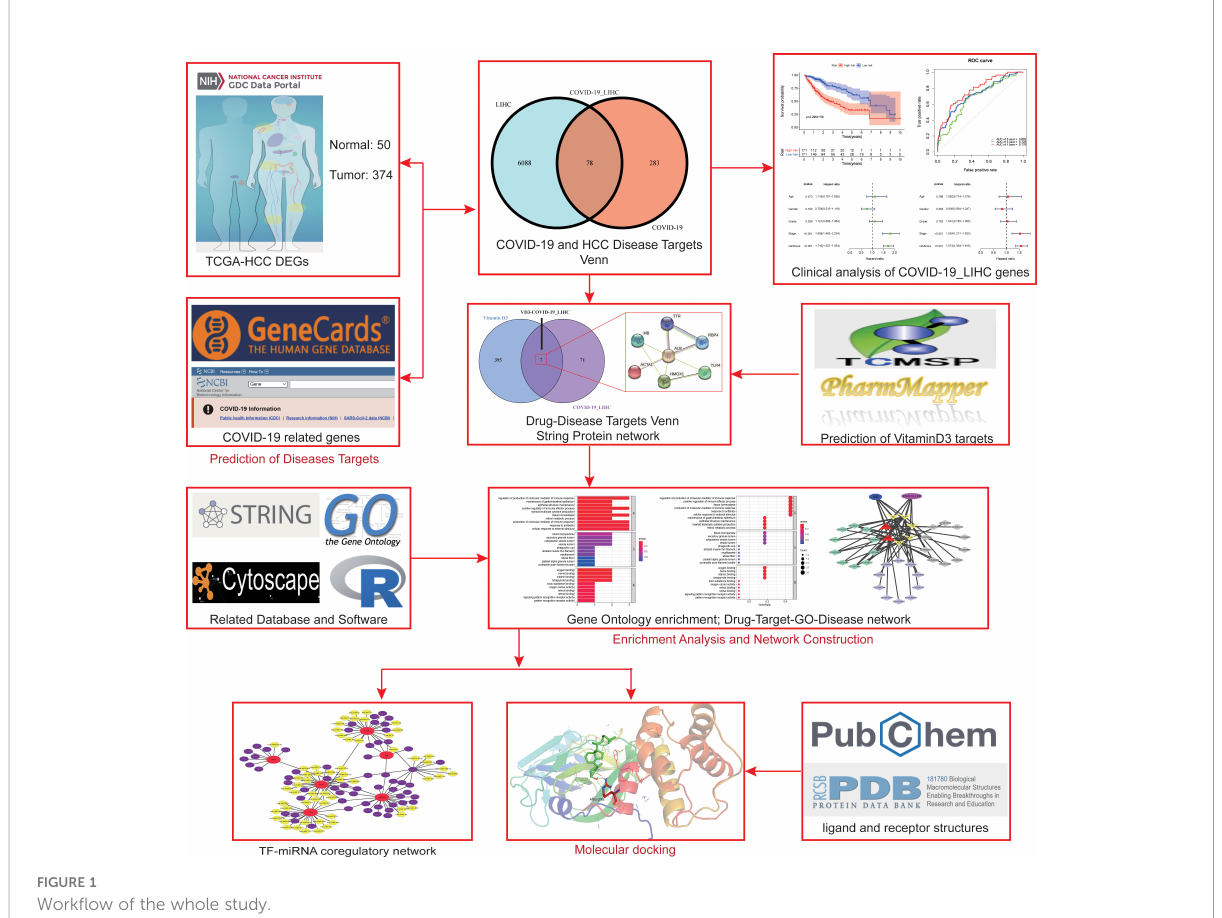
FIGURE 1 Work fl ow of the whole